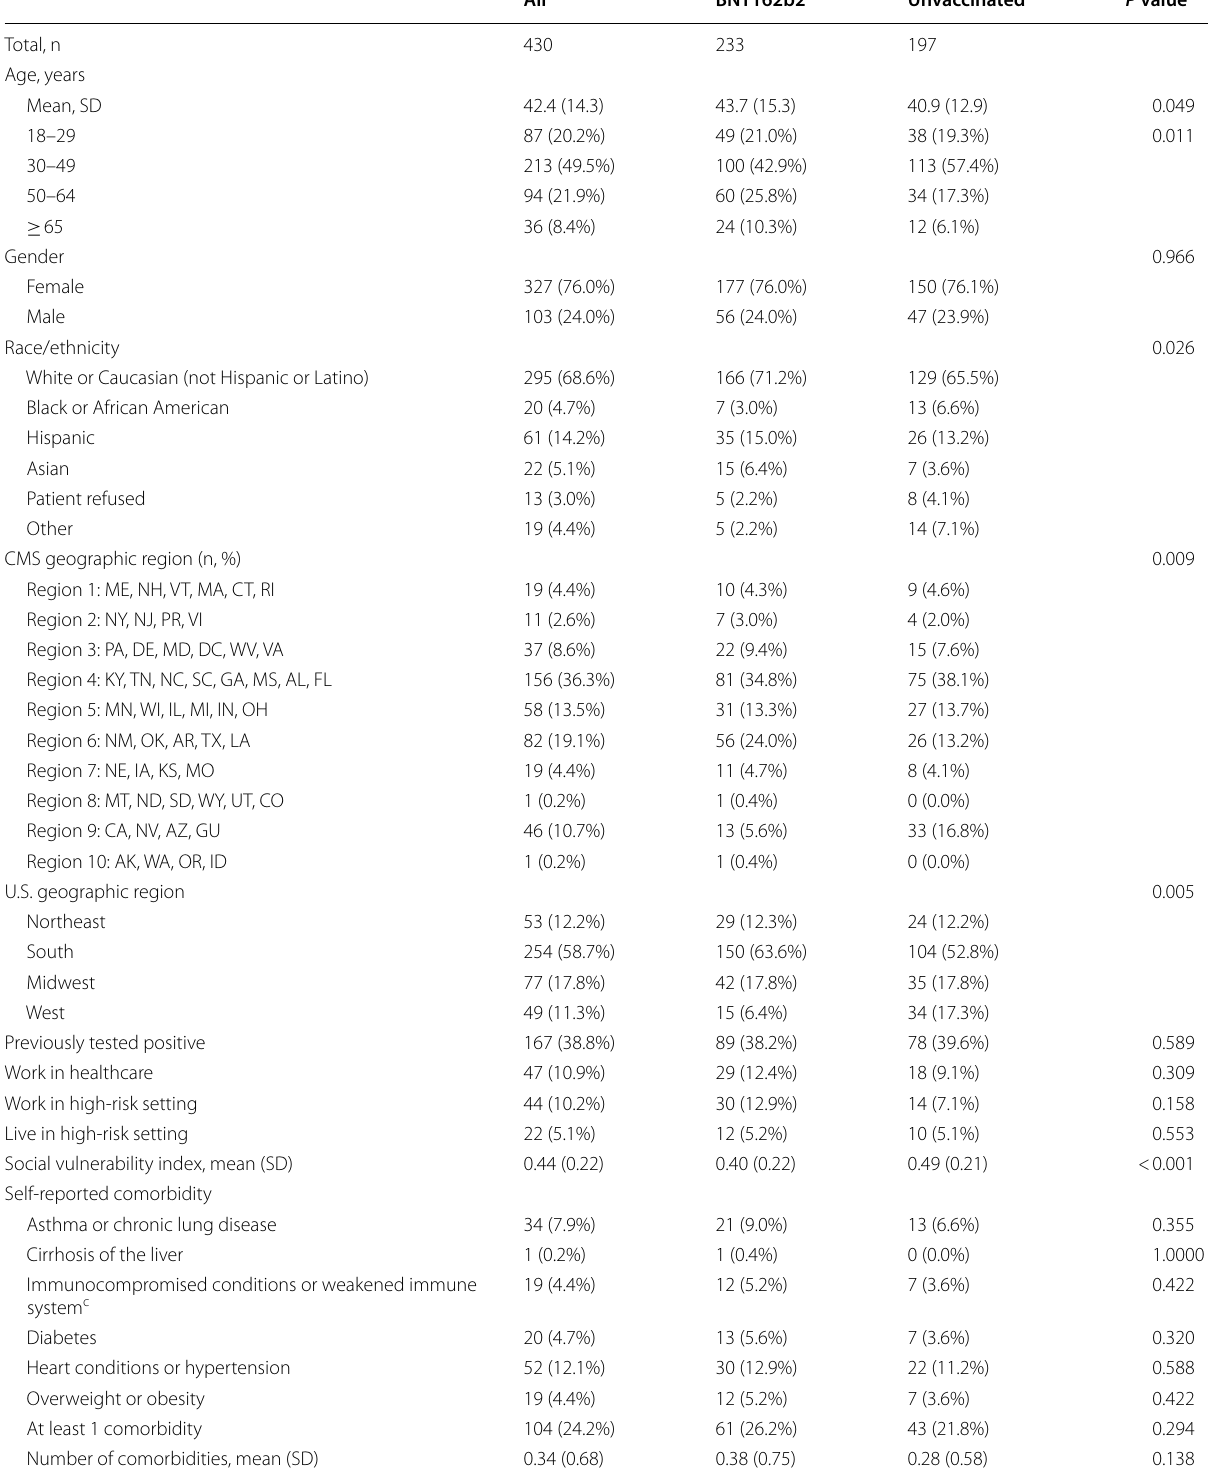
Table 1 Patient characteristics on index